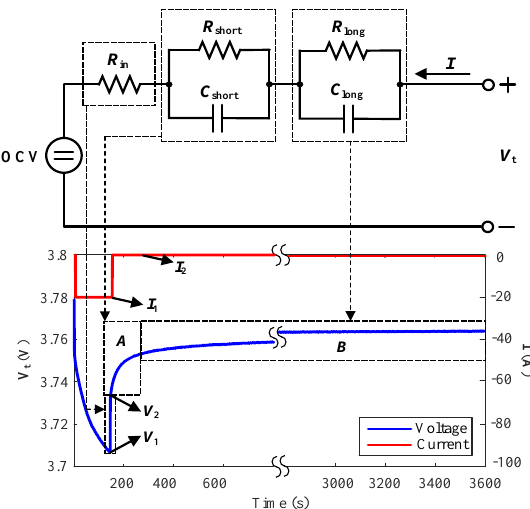
Figure 1. The second order equivalent circuit model (ECM). OCV , open circuit voltage.